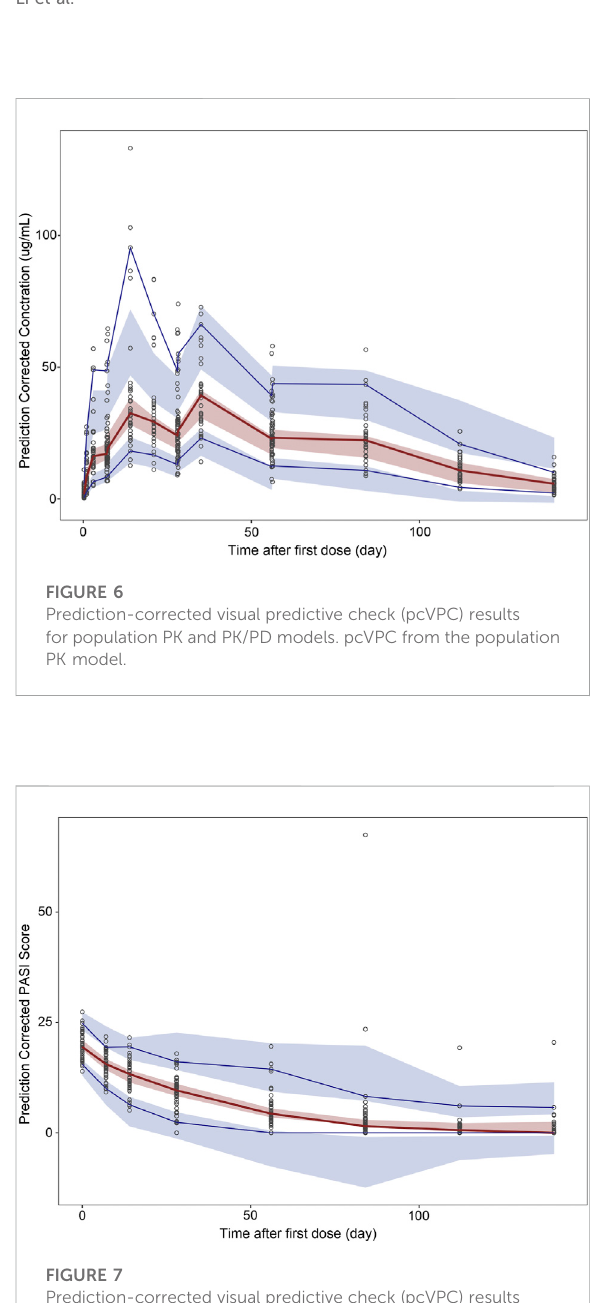
FIGURE 7 Prediction-corrected visual predictive check (pcVPC) results for population PK and PK/PD model. pcVPC from fi nal population PK/PD model. Black circles represent prediction-corrected observation points. Red solid lines represent the 50th percentiles and blue solid lines represent the 5th and 95th percentiles of prediction-corrected observations; Red shadows around the curves represent 90% con fi dence intervals of the 50th percentiles of prediction-corrected prediction and blue shadows represent90%con fi denceintervalsofthe5thand95thpercentiles for prediction-corrected